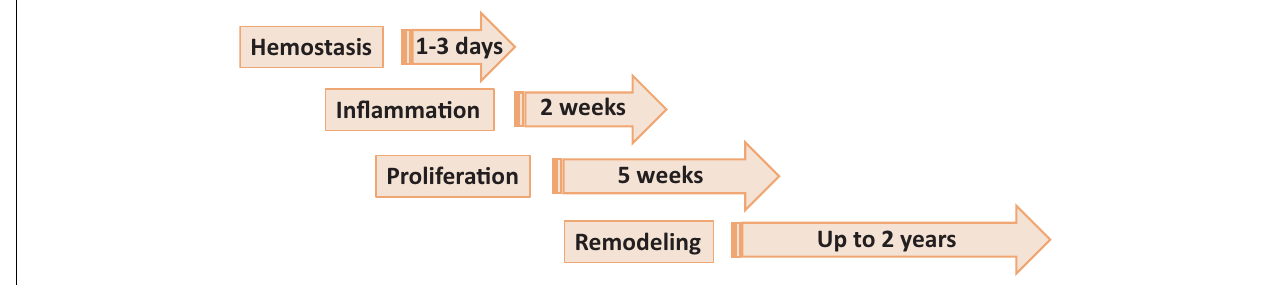
FIGURE 1 | Phases of wound healing. Phase 1, hemostasis is the process of clot formation to stop bleeding, and includes steps such as vasoconstriction, aggregation of platelets and migration of leukocytes. Phase 2, inflammation is the process of cleaning the wound and preparing for the formation of new blood vessels. It includes processes such as release of antibacterial molecules by neutrophils, engulfing of pathogens and debris by macrophages, and release of angiogenic substances to stimulation angiogenesis and granulation. Phase 3, proliferation (or granulation) – the process allowing to bring the wound edges together and seal it. It includes proliferation of the wound by fibroblasts, with secretion of glycoproteins and collagen, followed by migration of epithelial cells from the wound edges and formulation of granulation tissues. Phase 4, remodeling (or maturation) phase is mostly a continuation of proliferation phase resulting in formation of proper tissue.